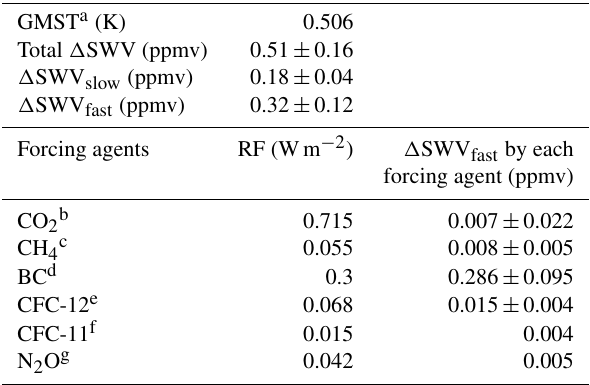
Table 2. Historical global average surface temperature change and radiative forcing (RF) by greenhouse gases (GHGs) and halocar- bons over 1980–2010. The SWV change over 1980–2010 esti- mated using PDRMIP results is also listed, including the total SWV change, the slow component, and the fast component. For the fast component of SWV change contributed by each forcing agent, multi-model mean results are listed. The uncertainties are 2.5–97.5 percentiles of the model samples. GMST a